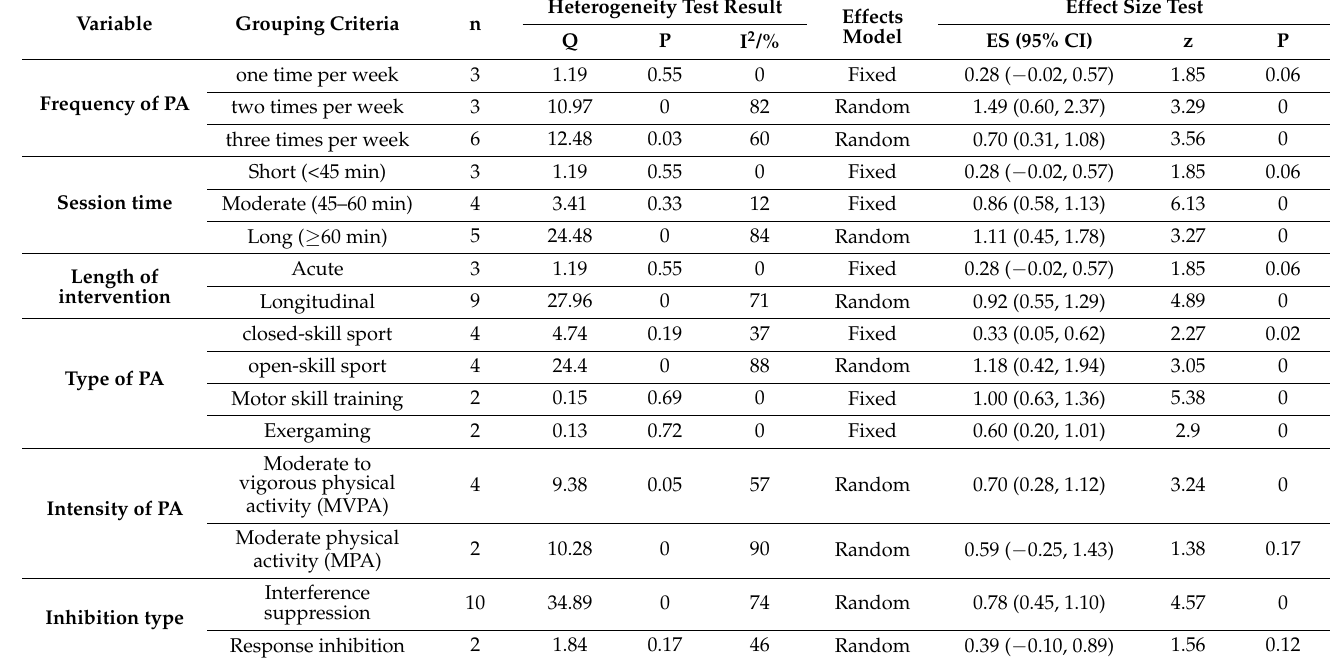
Table 3. Subgroup analysis of the effect of physical activity variables on